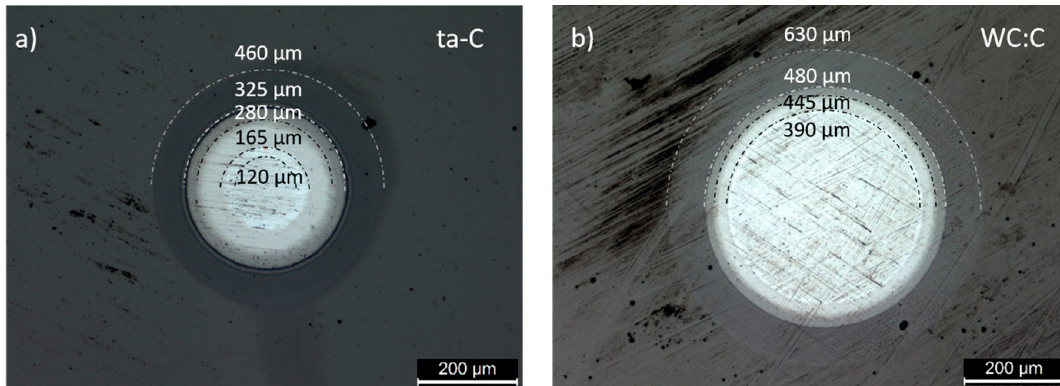
Figure 2. Calotest craters used to determine the resultant thickness for the ta-C coating ( a ) and sample coated by WC:C layer ( b ). The different numbers correspond to the different diameters of the rings exposed after the abrasion of the coating with the 30-mm balls used for the calculation of the different thicknesses. According to this method, the total thickness for the WC:C was around 2 µm, and the total thickness of the ta-C coating was 1.65 µm.